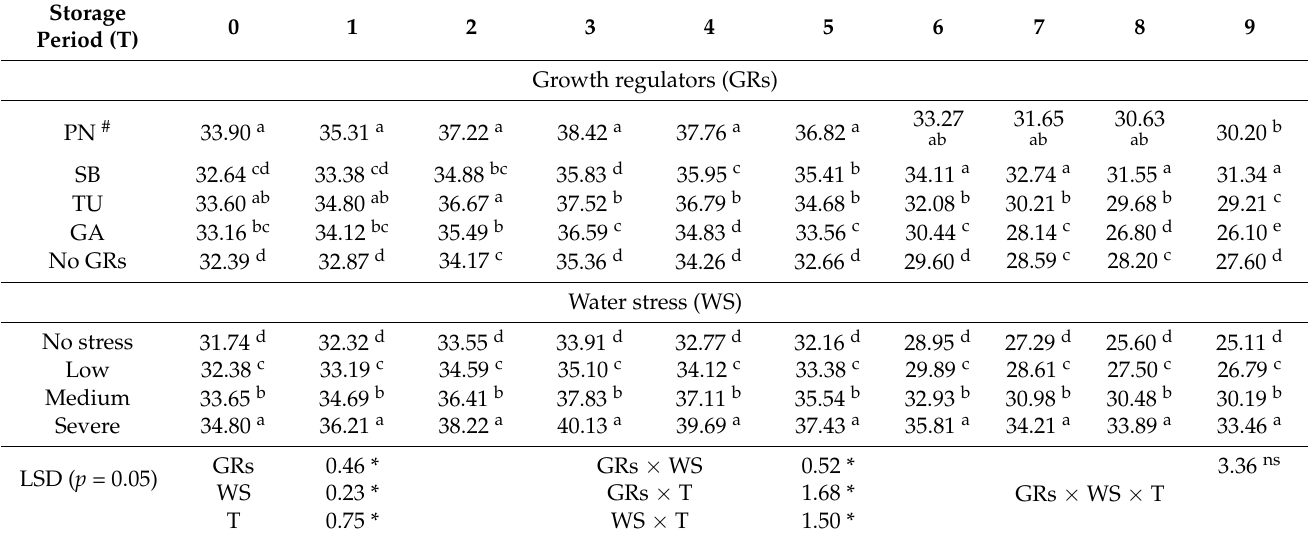
Table 3. Sugar content (mg/g FW) of onions as influenced under different GRs and water stress levels during 9 months of storage period.